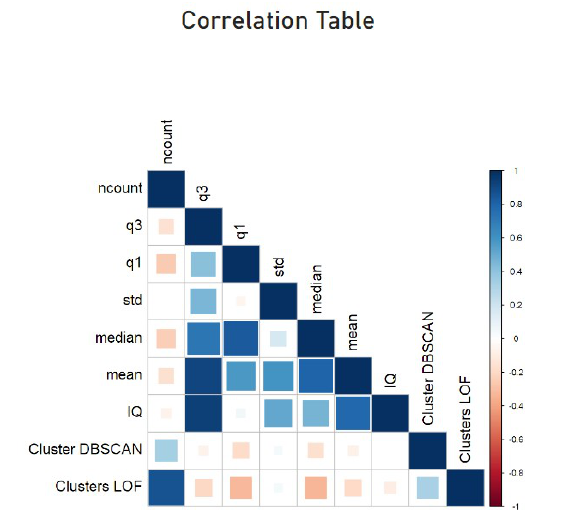
Figure 5. Correlation of DBSCAN and LOF to parameters.